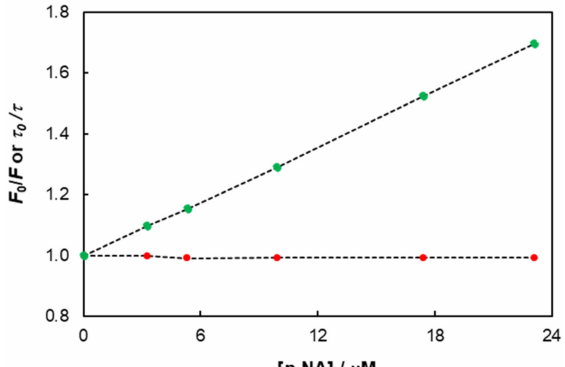
Figure 9. Steady-state (green dots) and time-resolved (red dots) Stern–Volmer plots of aqueous disper- sions of C-dots (0.01 mg/mL) in the presence of increasing amounts (3.26 × 10 − 6 M–23.1 × 10 − 6 M) of p -NA.